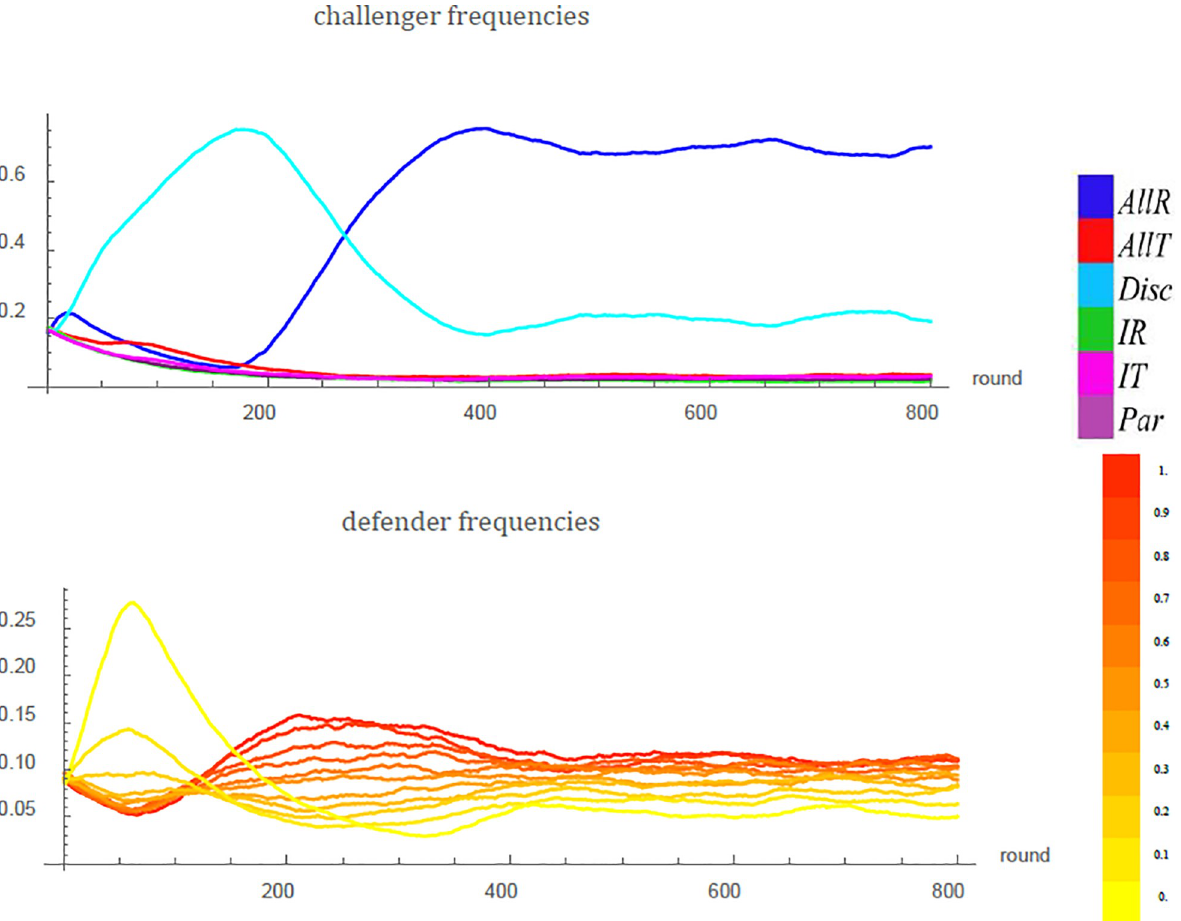
Fig 5. Evolution of deterrence in an example run of an agent-based simulation under the last-action reputation scheme. In the beginning, yielders (using strategy Q = 0, bright yellow) do best against the resident challengers, since takings are frequent. At the same time, discriminators (light blue) grow in frequency because discrimination pays off in the presence of a highly diverse defender population. However, this increases the value of having a tough reputation, and fighters ( Q = 1, red) become more numerous. As soon as the defenders’ average fighting probability is high enough, unconditional respecting (dark blue) takes over as it avoids paying the information costs. The frequency of this strategy oscillates around approximately 0.7, followed by discrimination with a frequency of approximately 0.2. Defenders’ property is mostly respected and just a small amount of taking and fighting remains. Parameter values: v = 1, c = 1.5, a = 0.1, N = 10 4 , N F = 100, d = 0.9, u = 10 − 2 , μ = � = δ = 10 − 3